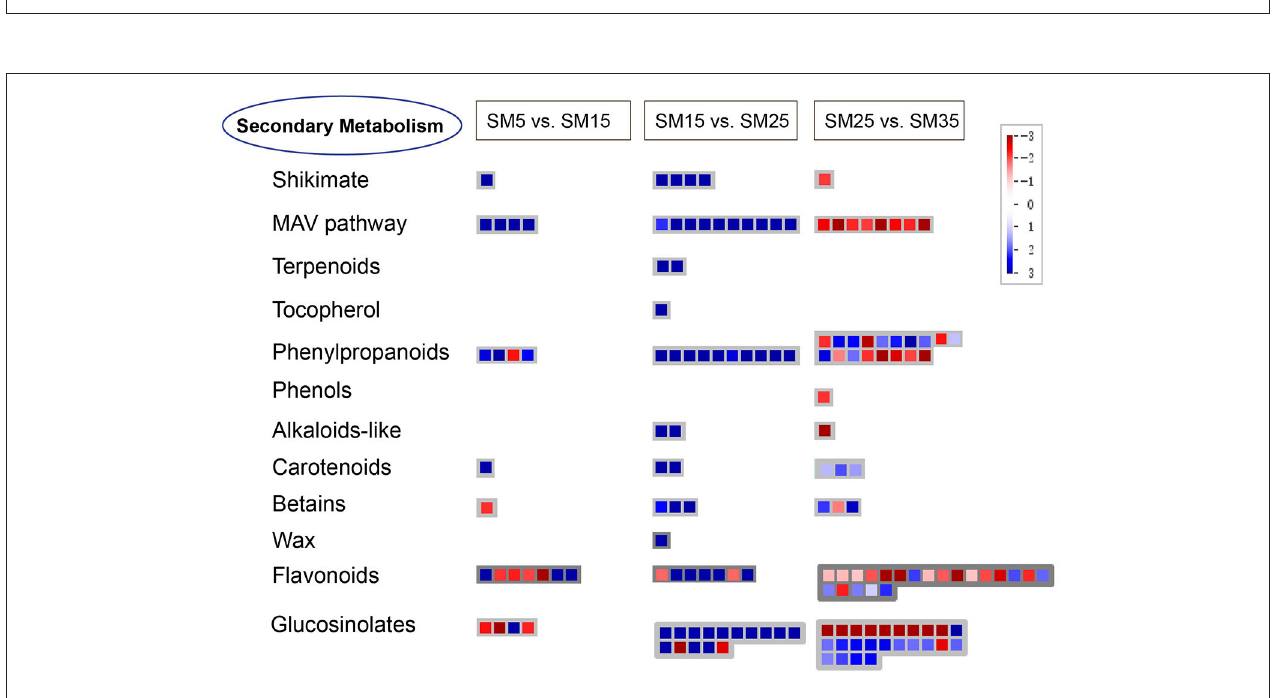
FIGURE 9 | Expression of unigenes in Chinese fir at four stages. (A) Numbers of DEGs in each comparison; (B) Venn diagram of analyses of differentially and stage-specific expression genes per comparison. SM5, SM15, SM25, and SM35 represent stand ages of 5, 15, 25, and 35 years, respectively.